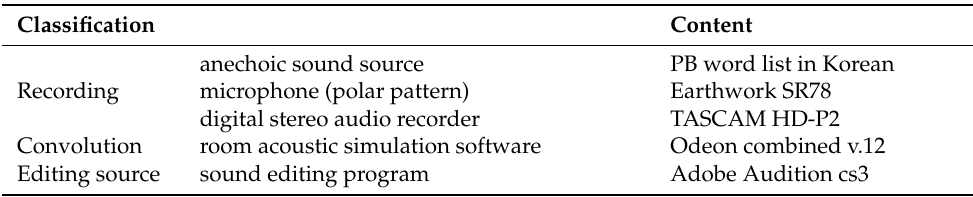
Table 5. The equipment list for producing auralized sound.